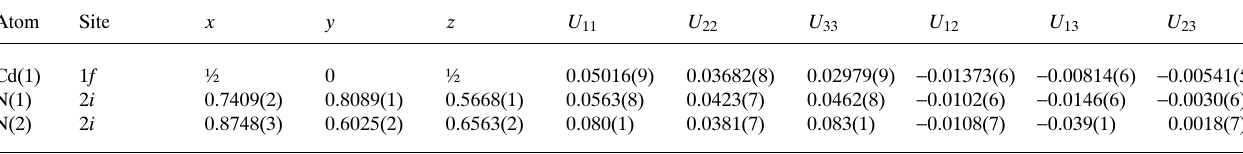
Table 3. Atomic coordinates and displacement parameters (in Å 2 )